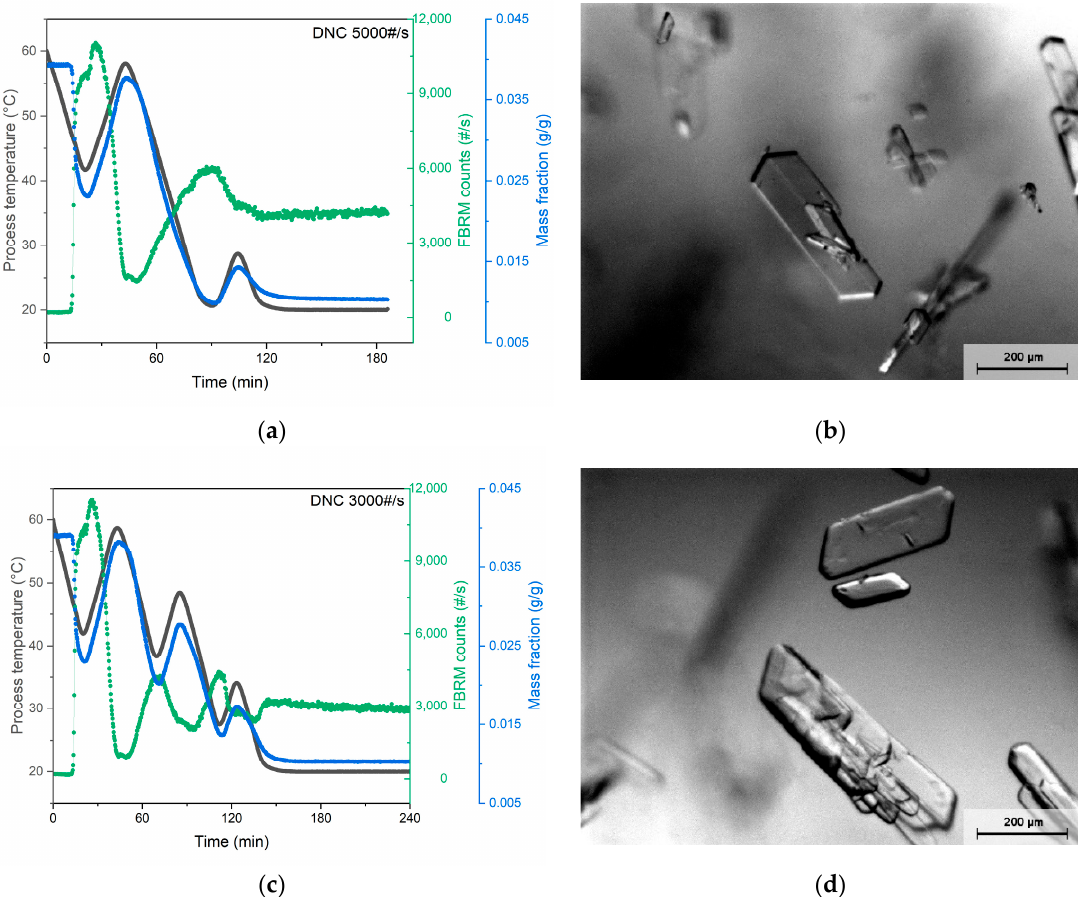
Figure 3. ( a ) Temperature ― , FBRM counts ― , and concentration ― profiles for experiment DNC-1 with target counts of 5000 #/s and ( b ) PVM image of final product crystals of DNC-1. ( c ) Temperature ― , FBRM counts ― , and concentration ― profiles for experiment DNC-2 with target counts of 3000 #/s, and ( d ) PVM image of final product crystals for DNC-2.